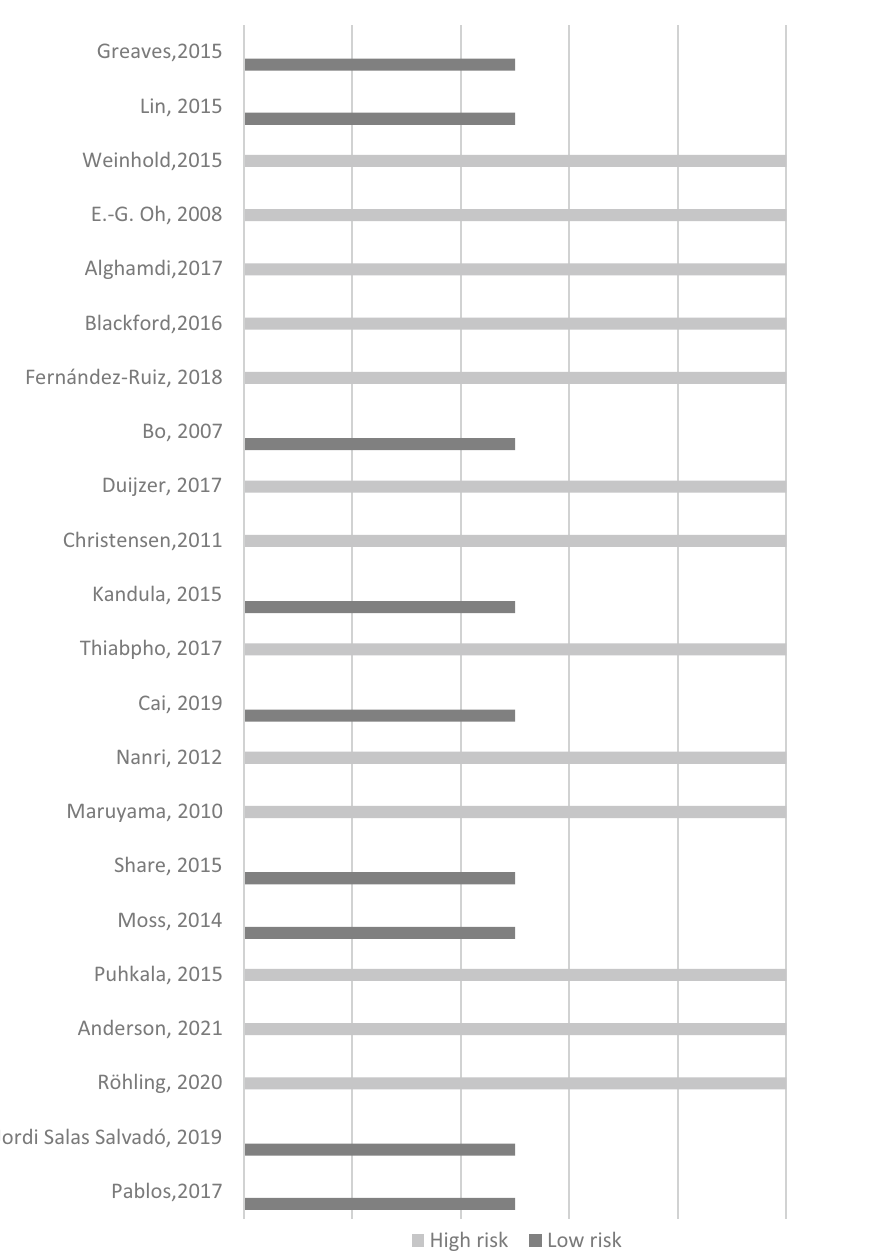
Figure 2. Quality assessment of the studies included in the review using Jadad